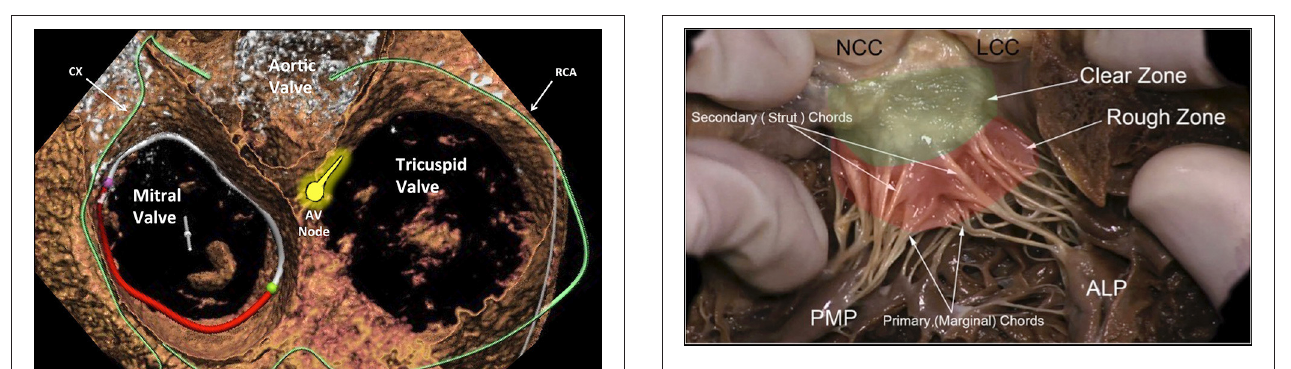
FIGURE 5 | The leaflets of the MV are clearly divided into two regions, the atrial zone which is at the base of the leaflets (green clear zone), thin and translucent, and the zone of coaptation, which is the distal rough and irregular zone (red rough zone), where numerous thick chordae origin and attach the leaflets to the PMs. Three types of chordae tendineae can be described: tertiary chordae which origin normally directly from the LV and are attached to the base of the posterior leaflets and commissure. The secondary chordae (Strut) extend directly from the PM and are attached to the body of the leaflets, ventricular side. The primary chordae (marginal), the most represented and robust, are attached to the free margin of the leaflets and the space between them is never more than 3mm. The attachment to the free margin is normally bifurcated or trifurcated. When they are considered upon their position, it is possible to recognize one thick and resistant ≪ main chorda ≫ attached to the ventricular surface of the leaflet which forms with the opposite main chord a kind of arcade, supporting the center part of the leaflet. The commissural chordae, attached to the commissural tissue, are trifurcated giving them the characteristic fan-like appearance. PMP, posterior mitral papillary; ALP, anterior leaflet papillary; NCC, non-coronary cusp; LCC, left coronary cusp. Courtesy of Dr. M. Reisman, University of